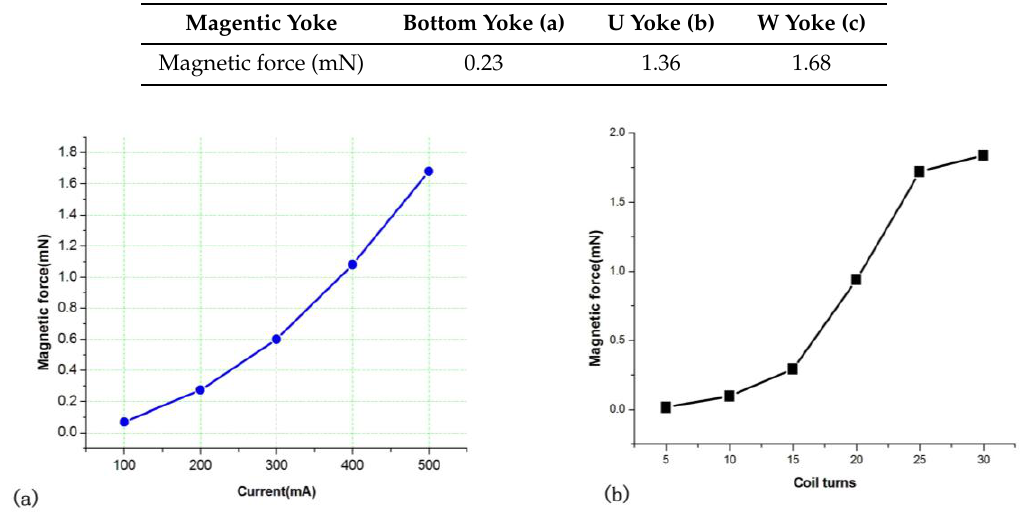
Table 4. The magnetic force with different magnetic yoke.